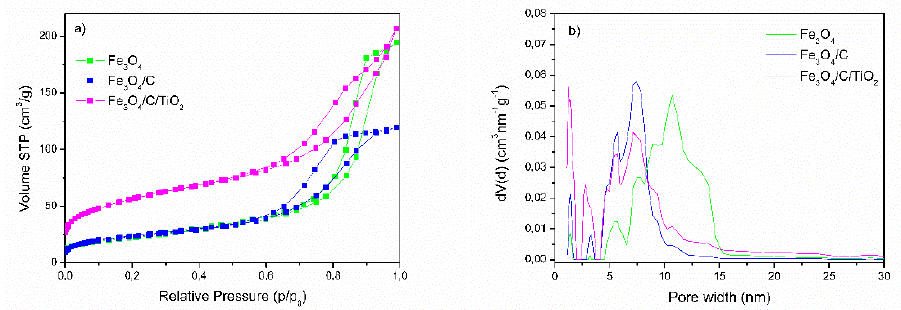
Figure 2. ( a ) Nitrogen adsorption isotherms (77K) and ( b ) pore size distribution calculated using the density functional theory (DFT) method.